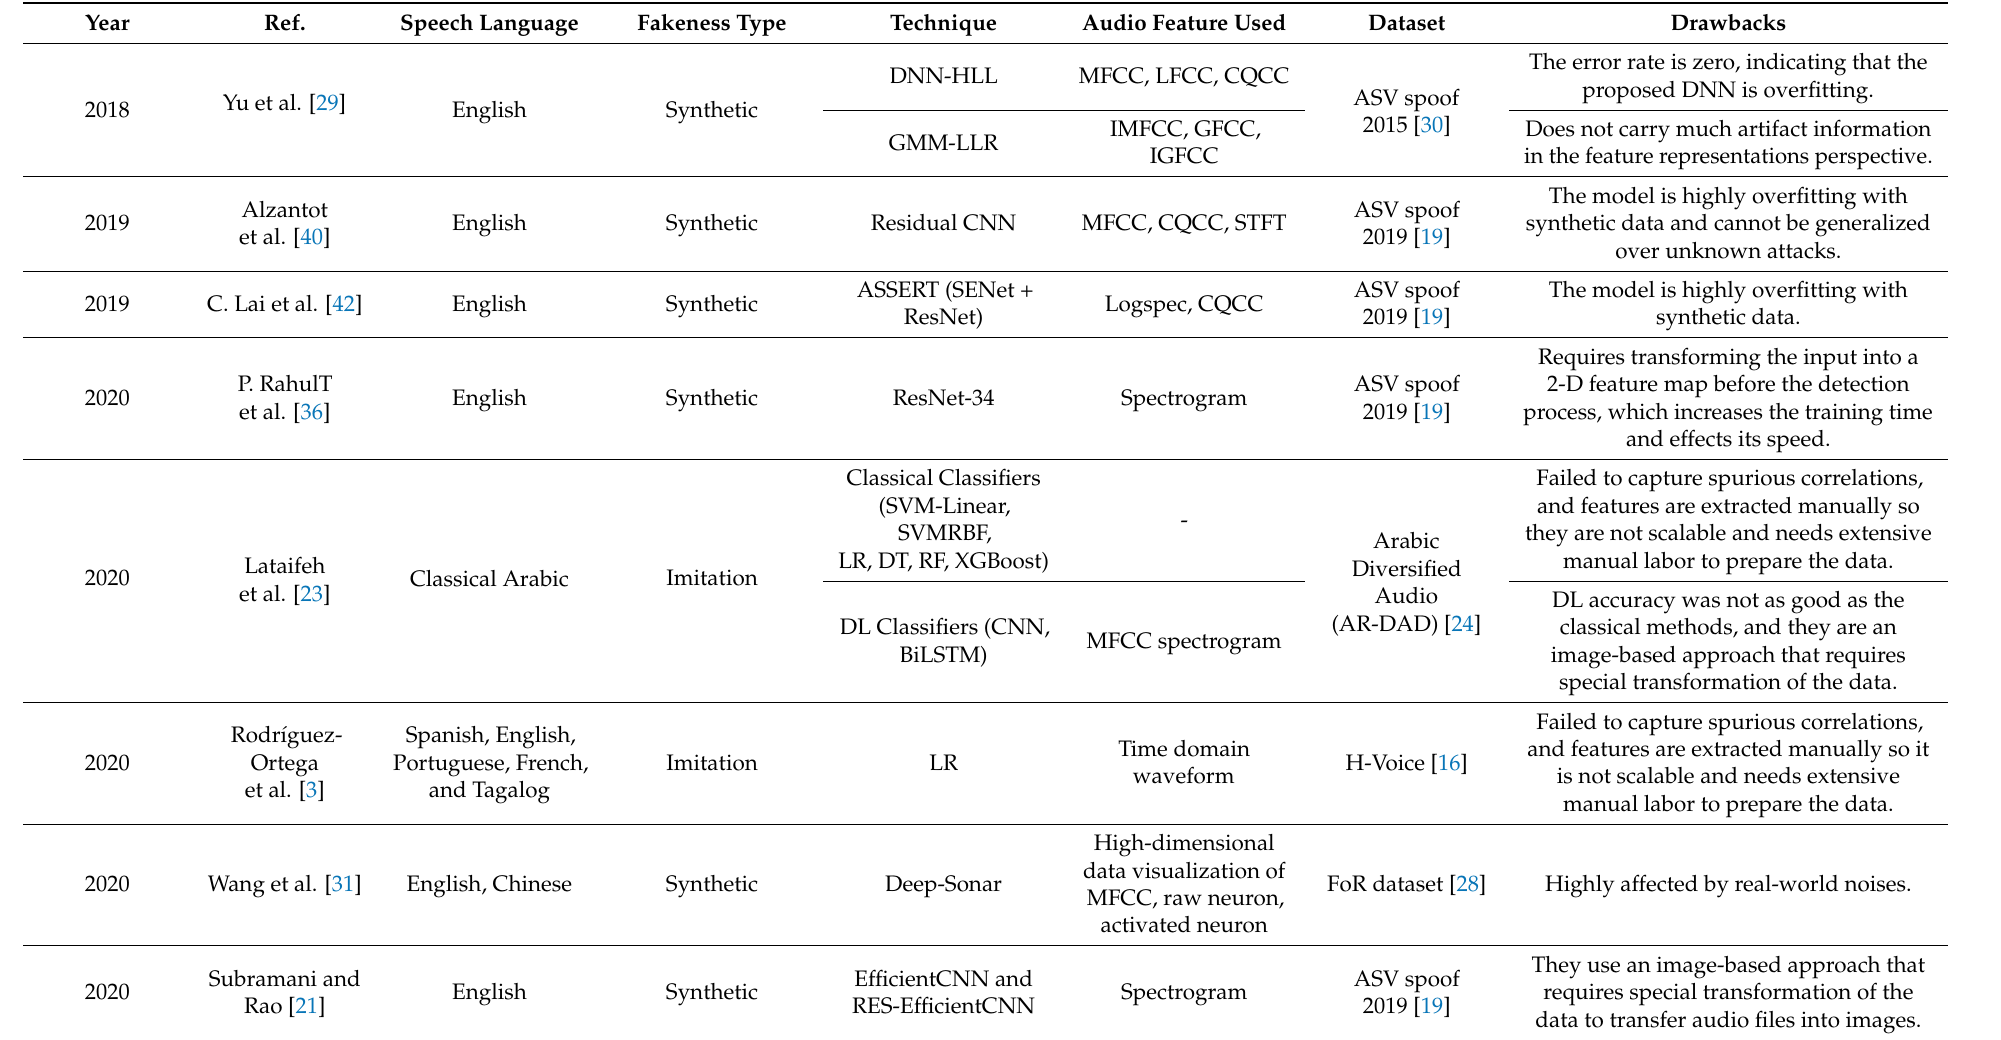
Table 1. Summary of AD detection methods studies